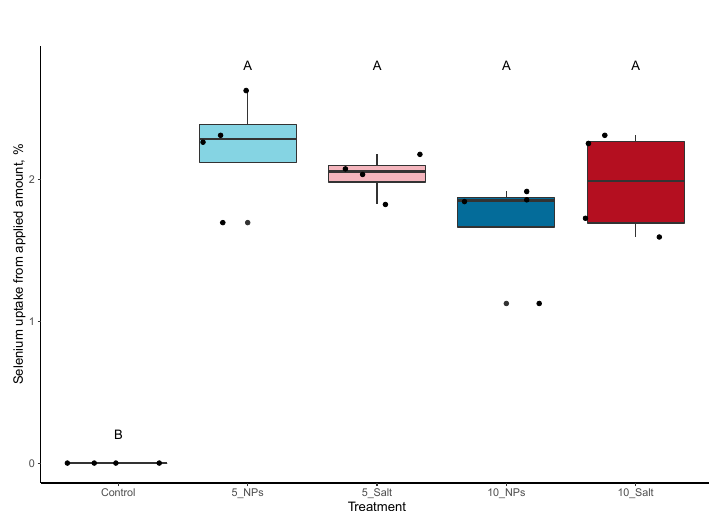
Figure A1. Percentage of total selenium cumulatively accumulated by different organs of the tomato plant (cv. Micro-Tom) 53 DAT at 0, 5, and 10 mg Se L − 1 as selenium nanoparticles (NPs) and sodium selenate (salt) in relation to the total amount distributed for each of the tested treatments. Bars indicate standard error. Values with the same letter are not statistically different ( p ≤ 0.05; n = 4).